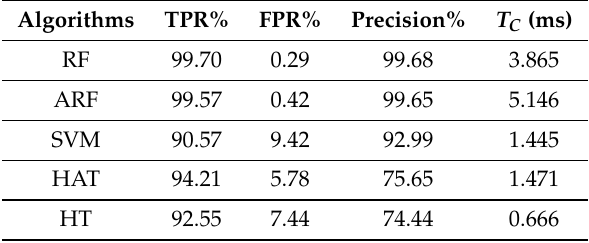
Figure 4. Modeling evaluation; ( a ) Accuracy evaluation, ( b ) MCC evaluation. Table 5. T C and metrics derived from the confusion matrix. TPR: true positive rate; FPR: false positive rate; RF: Random Forest; ARF: Adaptive Random Forest; SVM: Support Vector Machine; HAT: Hoeffding Adaptive Tree; HT: Hoedding